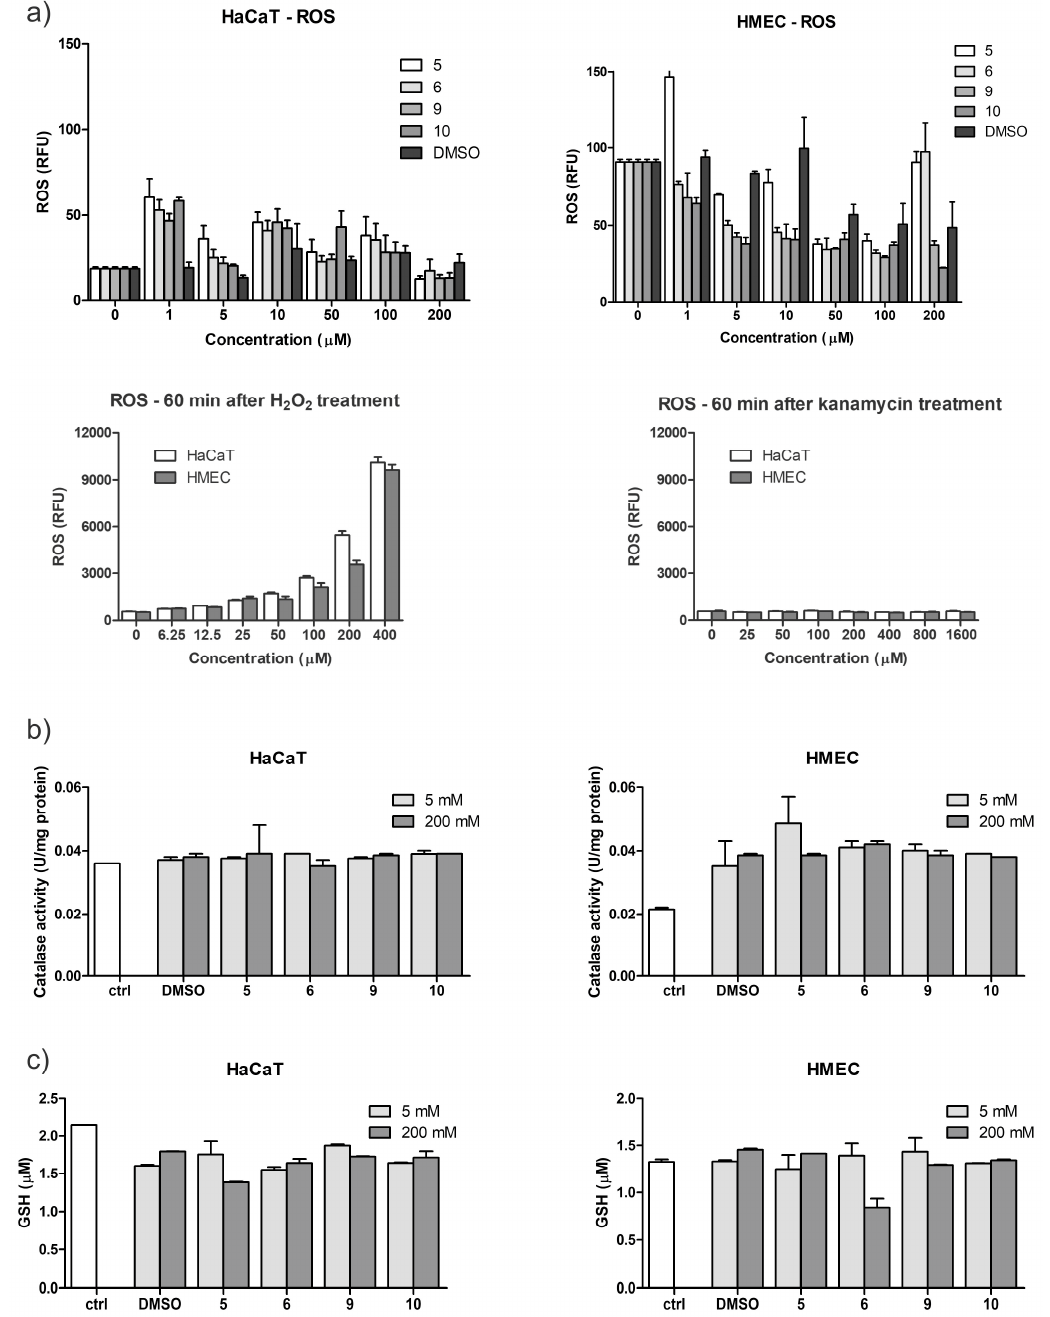
Figure 5. Tests of the ability of compounds 1 – 10 to change ( a ) intracellular ROS levels with assay controls H 2 O 2 and kanamycin; ( b ) cellular antioxidative defense system GSH; and ( c ) catalase.